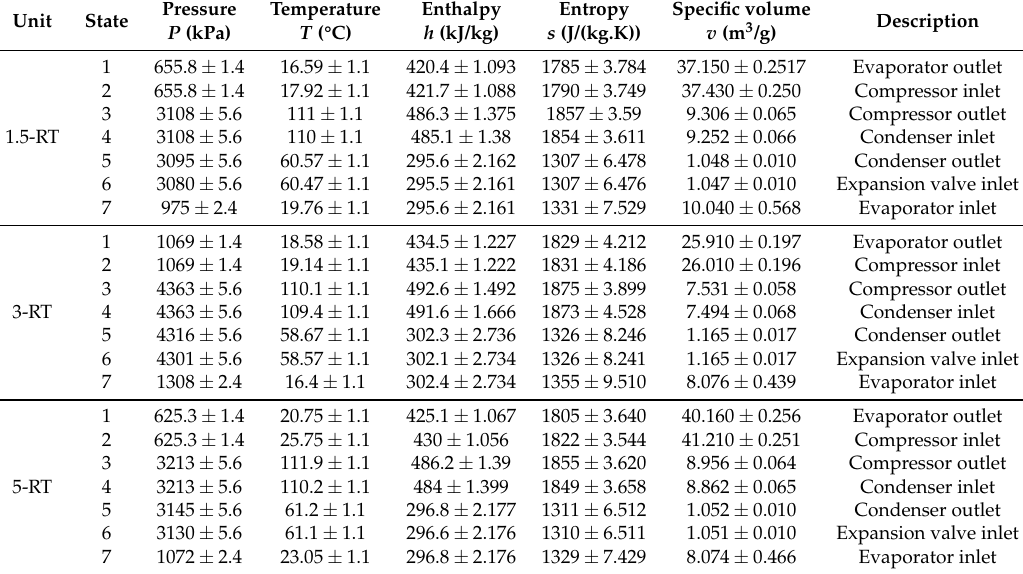
Table 3. Thermodynamics properties measured and calculated for 1.5-RT, 3-RT, and 5-RT ECUs at all state points for Test Condition